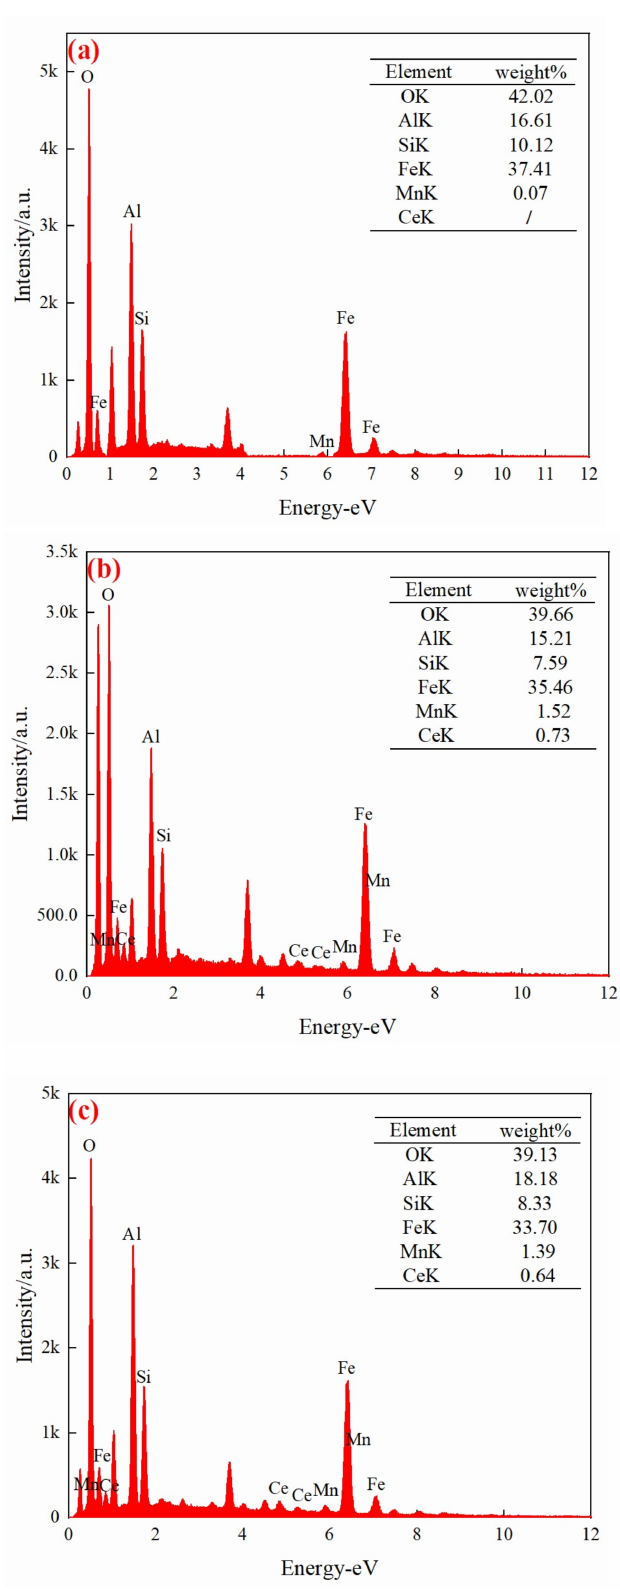
Figure 3. EDS characterization results: ( a ) Red mud blank sample; ( b ) Optimal Mn/Ce@RM catalyst sample; ( c ) Mn/Ce@RM catalyst reused 25